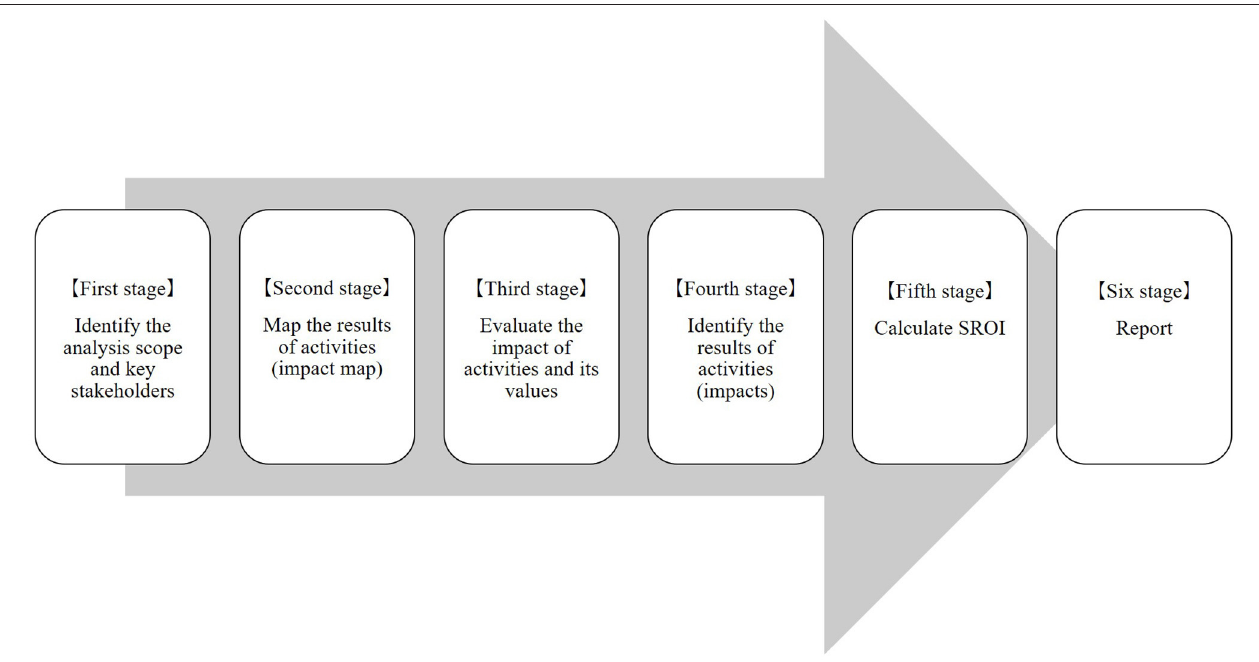
FIGURE 1 | The stages of